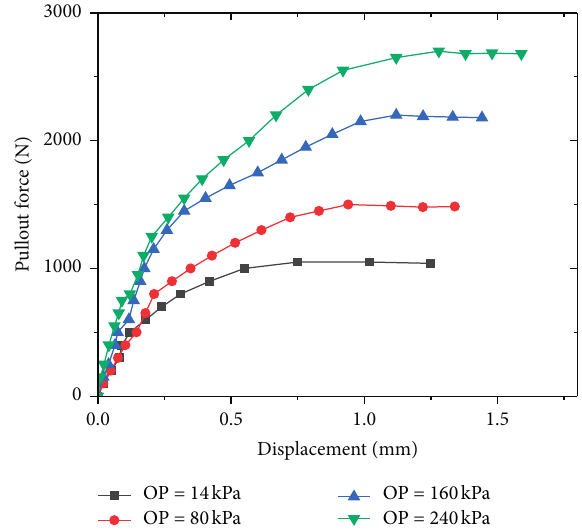
Figure 11: Curves of displacement of nail head with pullout